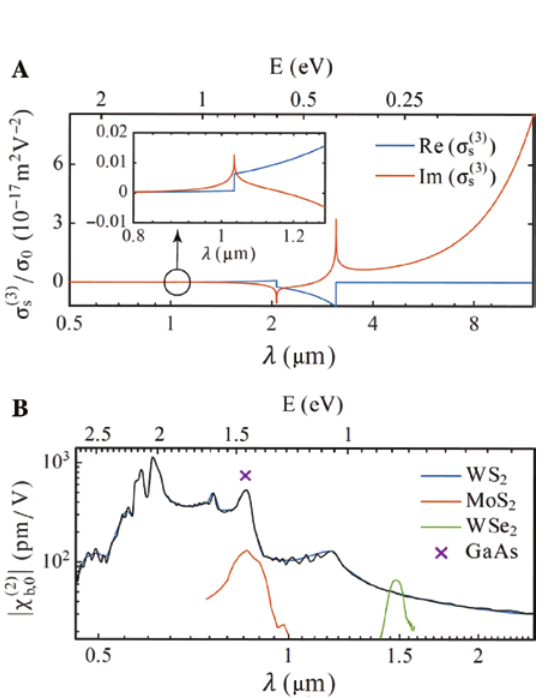
Figure 3: Nonlinear optical properties of 2D materials. (A) third-order surface conductivity of graphene and (B) effective second-order bulk susceptibility of TMDC and the value of the dominant component of second-order bulk susceptibility for GaAs. Reproduced from Ref.